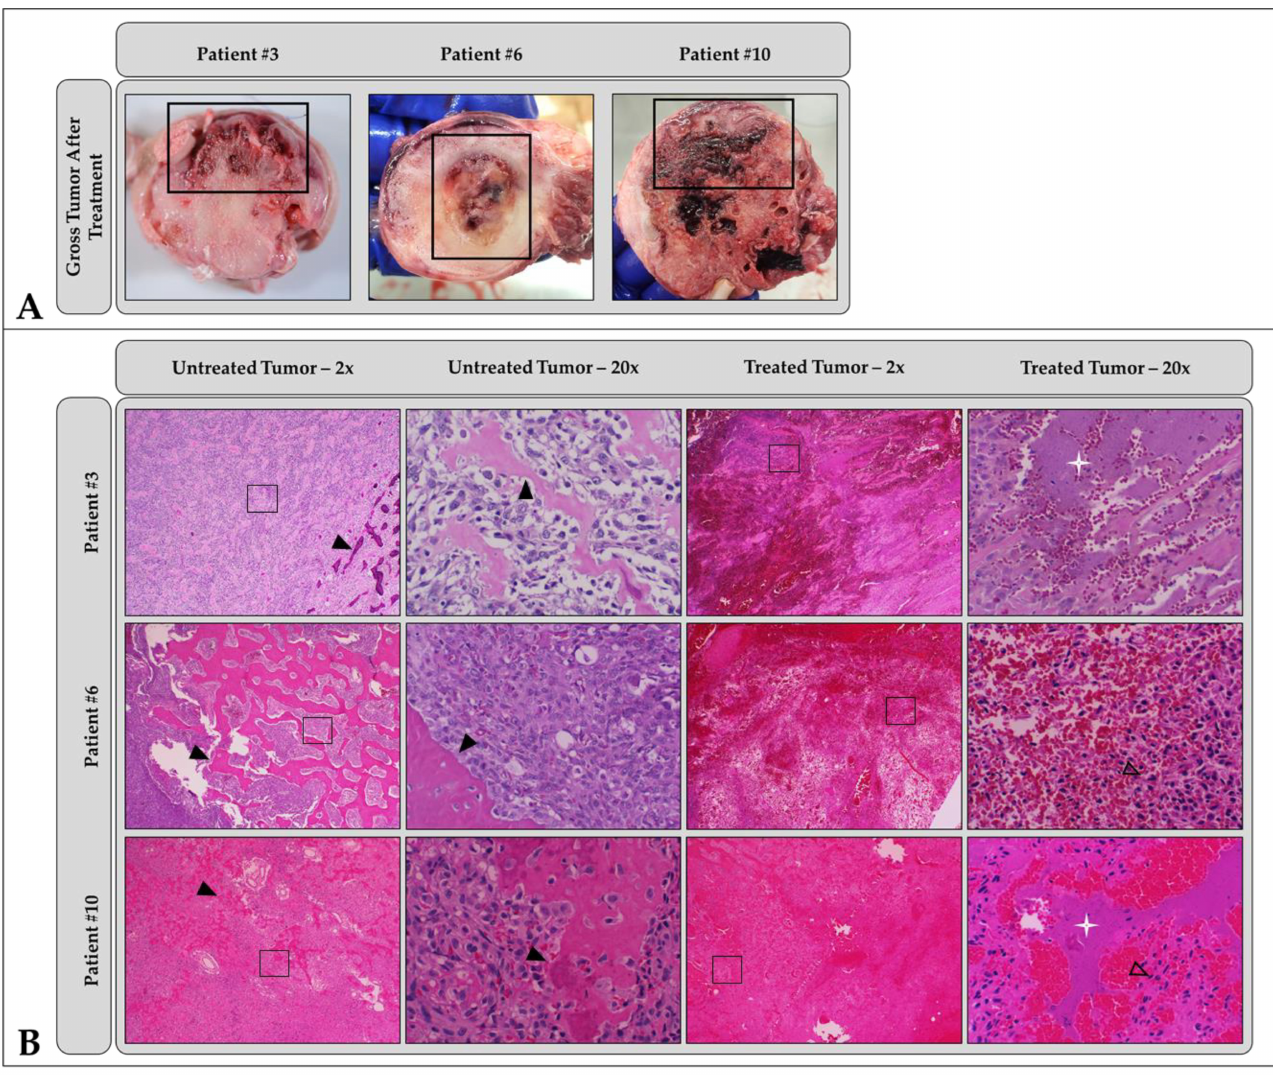
Figure 3. Patient-matched ( A ) gross pathology and ( B ) low- (2 × ) and high-magnification (20 × ) microscopic histology images comparing treated and untreated OS tumor regions. In all patients shown, histotripsy-treated regions of the tumor (thick black boxes in ( A )) were characterized by hemorrhage, tissue softening, and/or necrosis. Sections from untreated areas of OS tumors showed dense proliferation of neoplastic osteoblasts variably surrounding the osteoid matrix (black arrow- heads). In contrast, sections from treated tumors exhibited hemorrhage and necrosis, abundant cell death (empty arrowheads identify dead or dying cells), complete tissue obliteration with replacement basophilic slipping (white star), and/or matrix degeneration (not shown). Patient-specific ablation details can be found in Table 5. Images in columns 2 and 4 of ( B ) were taken from boxed regions in columns 1 and 3,